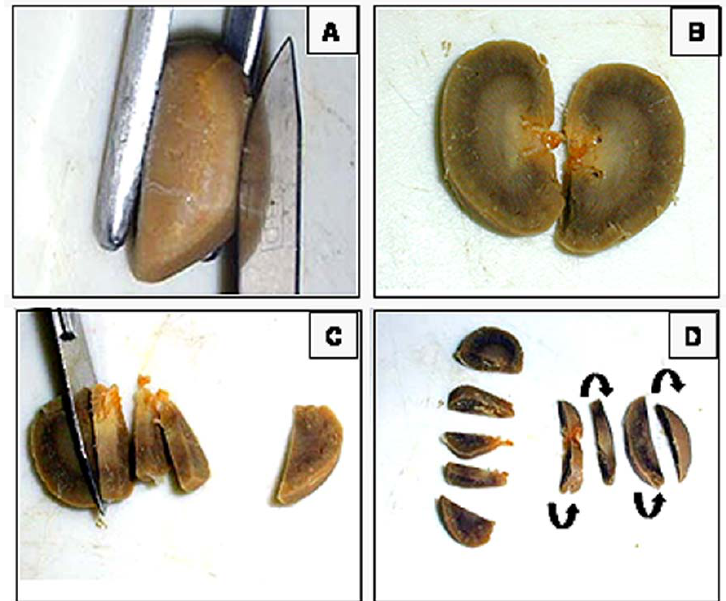
Fig. 9 – Generalization of the vertical section method in rat kidney. For the kidney, select an arbitrary horizontal reference plane (e.g. the laboratory bench). Once a reference plane has been selected for a particular object it is then considered as fixed. Generate an isotropic orientation in the horizontal plane (A and B). Section the kidney with uniform random position along this orientation (C and D). The object is given an isotropic rotation on the horizontal plane (D). A cycloid arcs test-system (Figure 11) must be used with these